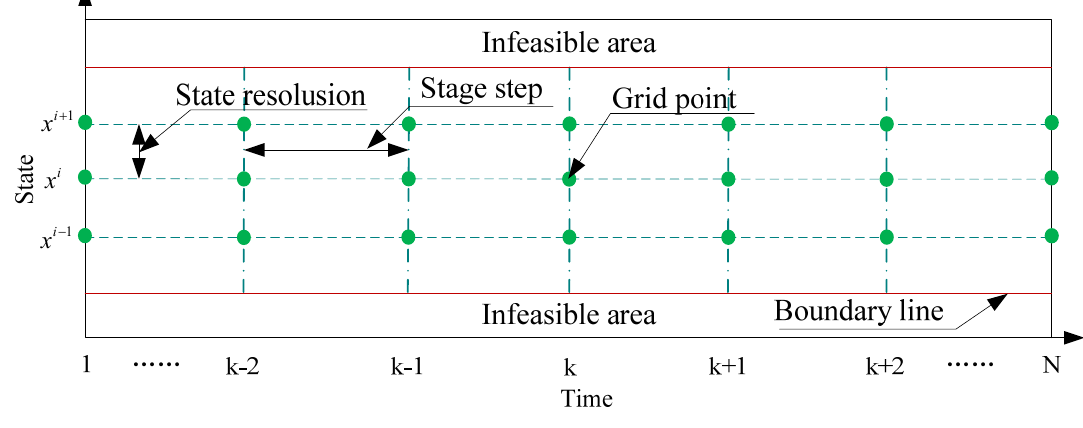
Figure 1. Discretization of the state space and time